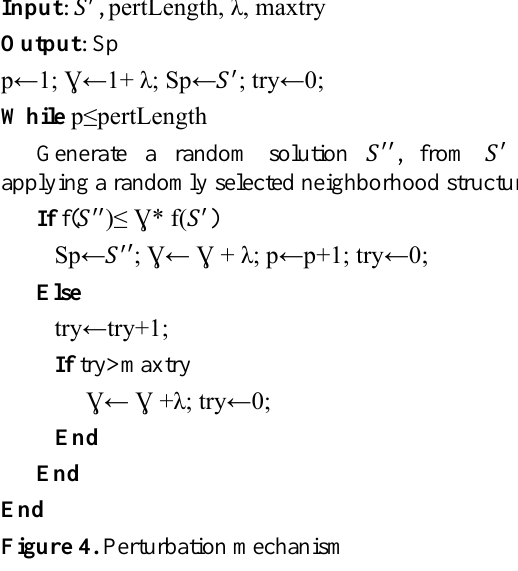
Figure 4. Perturbation